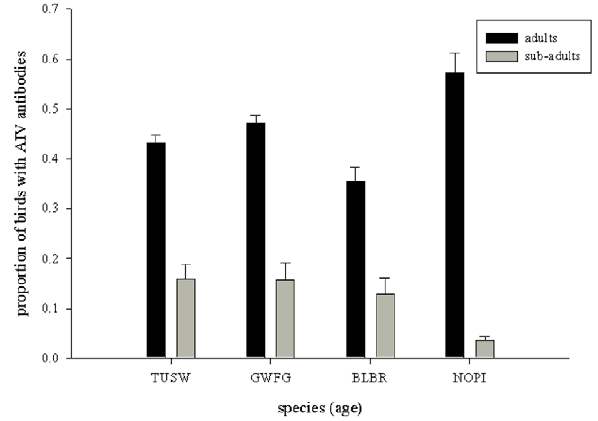
Figure 3. Age differences in seroprevalence rates ( ± s.e.) of avian influenza virus (AIV) antibodies between adult and sub- adult tundra swans (TUSW), greater white-fronted geese (GWFG), black brant (BLBR), and northern pintails (NOPI) in Alaska. Overall, adults had.7.7 (95% CI: 5.7–10) times greater probability of having AI antibodies than did sub-adults.